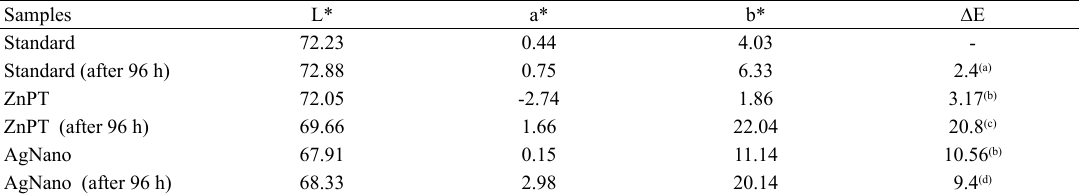
Table 2. Color analysis of Standard samples and TPE incorporated with 1.5% of ZnPT and 1.5% of AgNano before and after 96 h of UV light